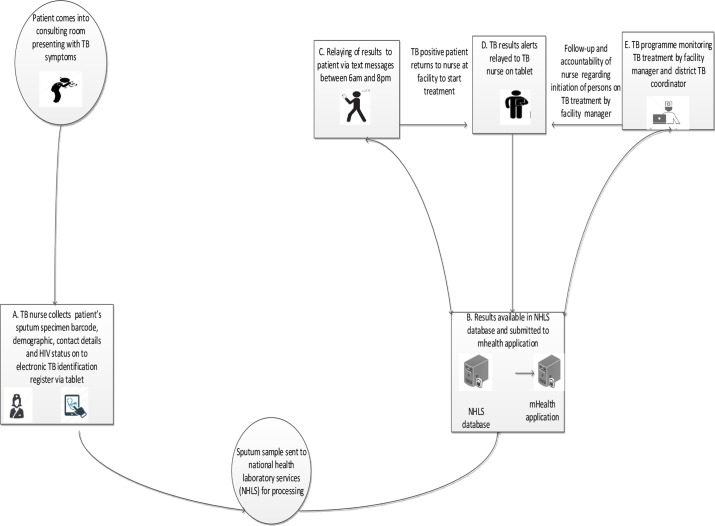
Illustration of the direction of communication between laboratory, health care worker and patient during TB case investigation.NHLS: National Health Laboratory Services; TB: Tuberculosis.